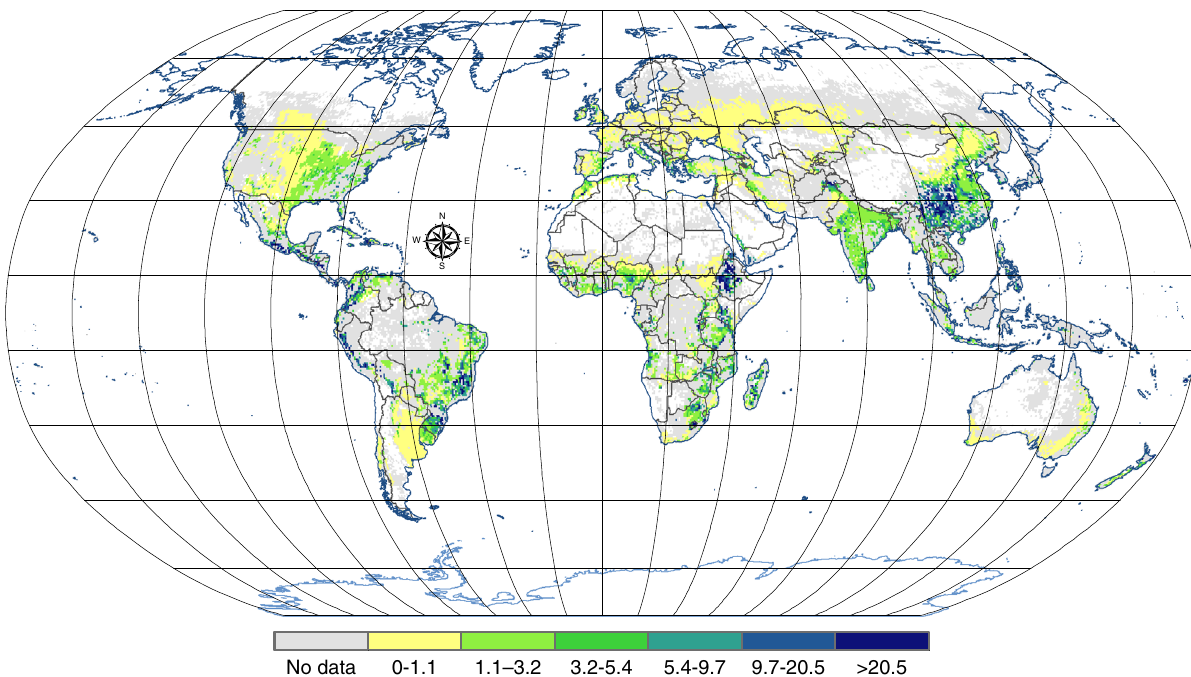
Fig. 2 Global average phosphorus (P) losses due to soil erosion in kg ha − 1 yr − 1 . The chromatic scale represents the P losses estimates, while the gray color indicates the cropland areas that were excluded from the modeling due to data unavailability. Note that classes are not regularly scale ranked but are divided into six classes using the quantile classi fi cation method. Only plant available fractions were considered. For the more residual P fractions please refer to Table 1 or Figs. 3 and 4).